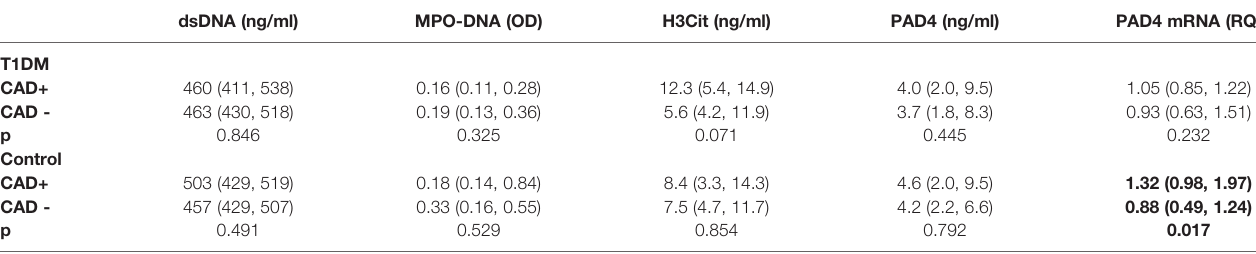
TABLE 2 | Levels of NETs markers according to the presence of CAD.